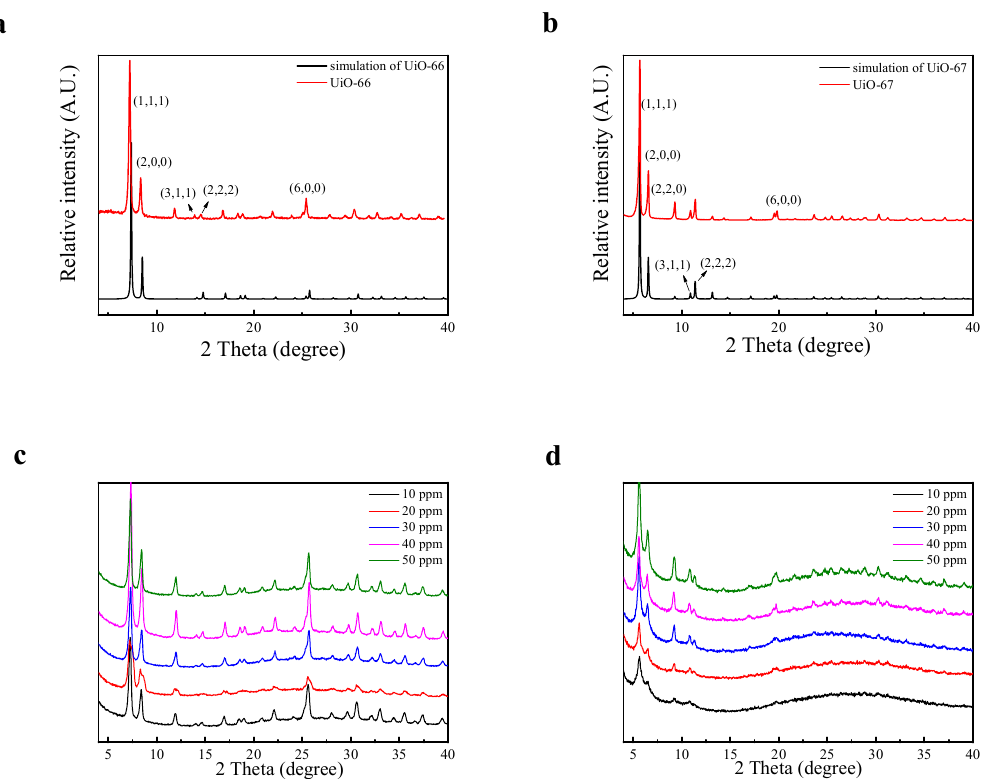
Figure 3. Powder X-ray diffraction (PXRD) patterns of ( a ) UiO-66, ( b ) UiO-67, ( c ) UiO-66 after adsorption, and ( d ) UiO-67 after adsorption.